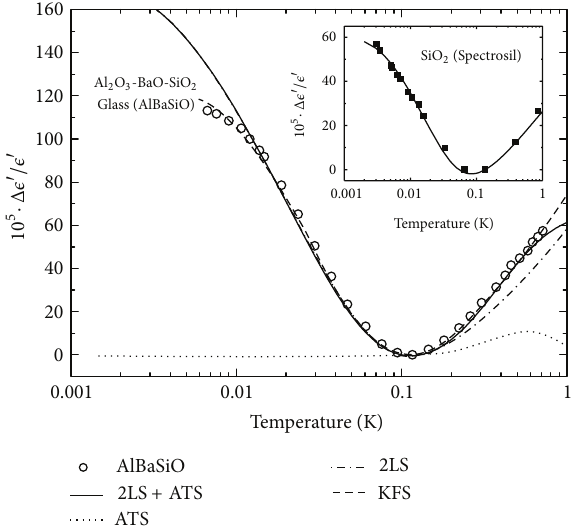
Figure 7: Dielectric signature of pure 𝑎 -SiO 2 (inset) and AlBaSiO (main) glasses. SiO 2 data [53], fitted with (8), display a − 2:1 2LS-TM behavior. AlBaSiO data [54] display rather a − 1:1 behavior, yet could be fitted with (8) (dashed line) [54] with a large Δ 0 min = 12.2 mK 2LS tunneling parameter. We have fitted all data with a more realistic = 3.9 mK and best fit parameters from Table 1 using (8) and Δ 0 min (14) (driving frequency 𝜔 = 1 kHz).